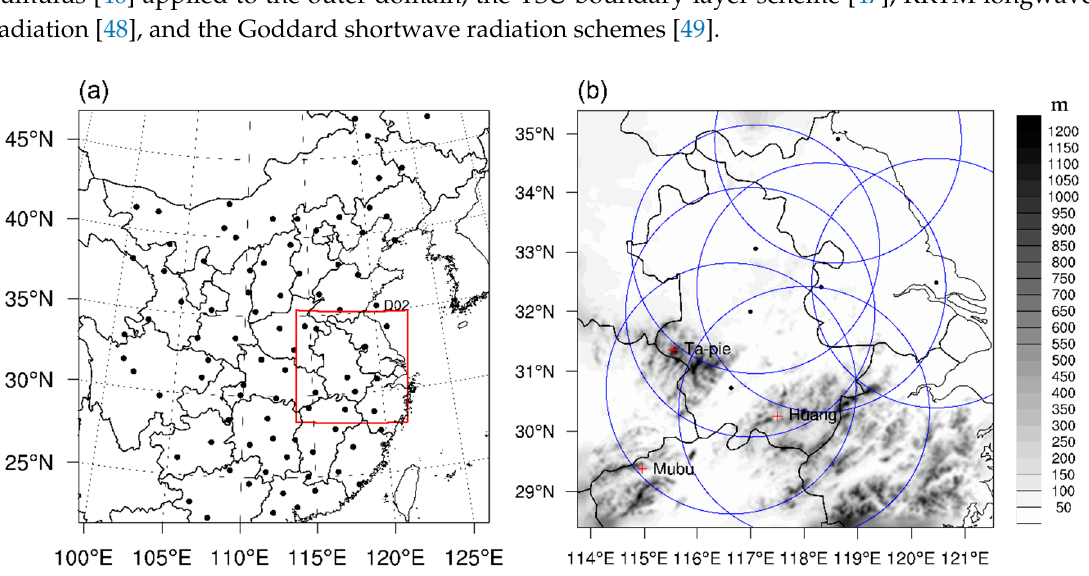
Figure 1. ( a ) Configuration of model domain. The red square indicates the inner domain and the black dots show the distribution of the simulated sounding datasets. ( b ) Terrain height (m) within the inner domain. Blue circles show the coverages of the seven radar sites.